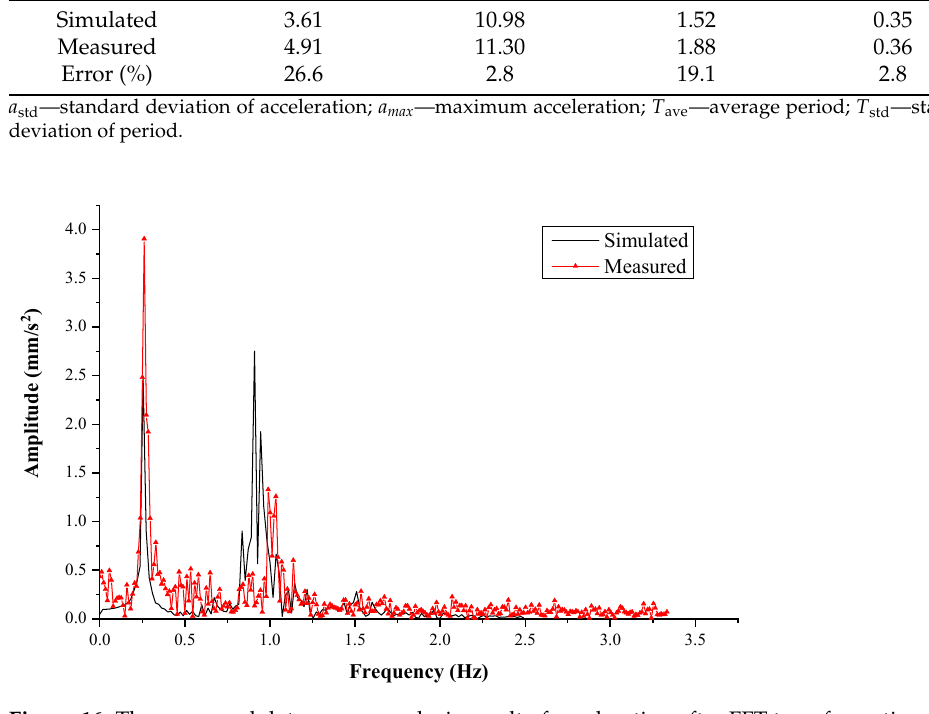
Table 5. Comparison of peak frequency between simulated value and measured